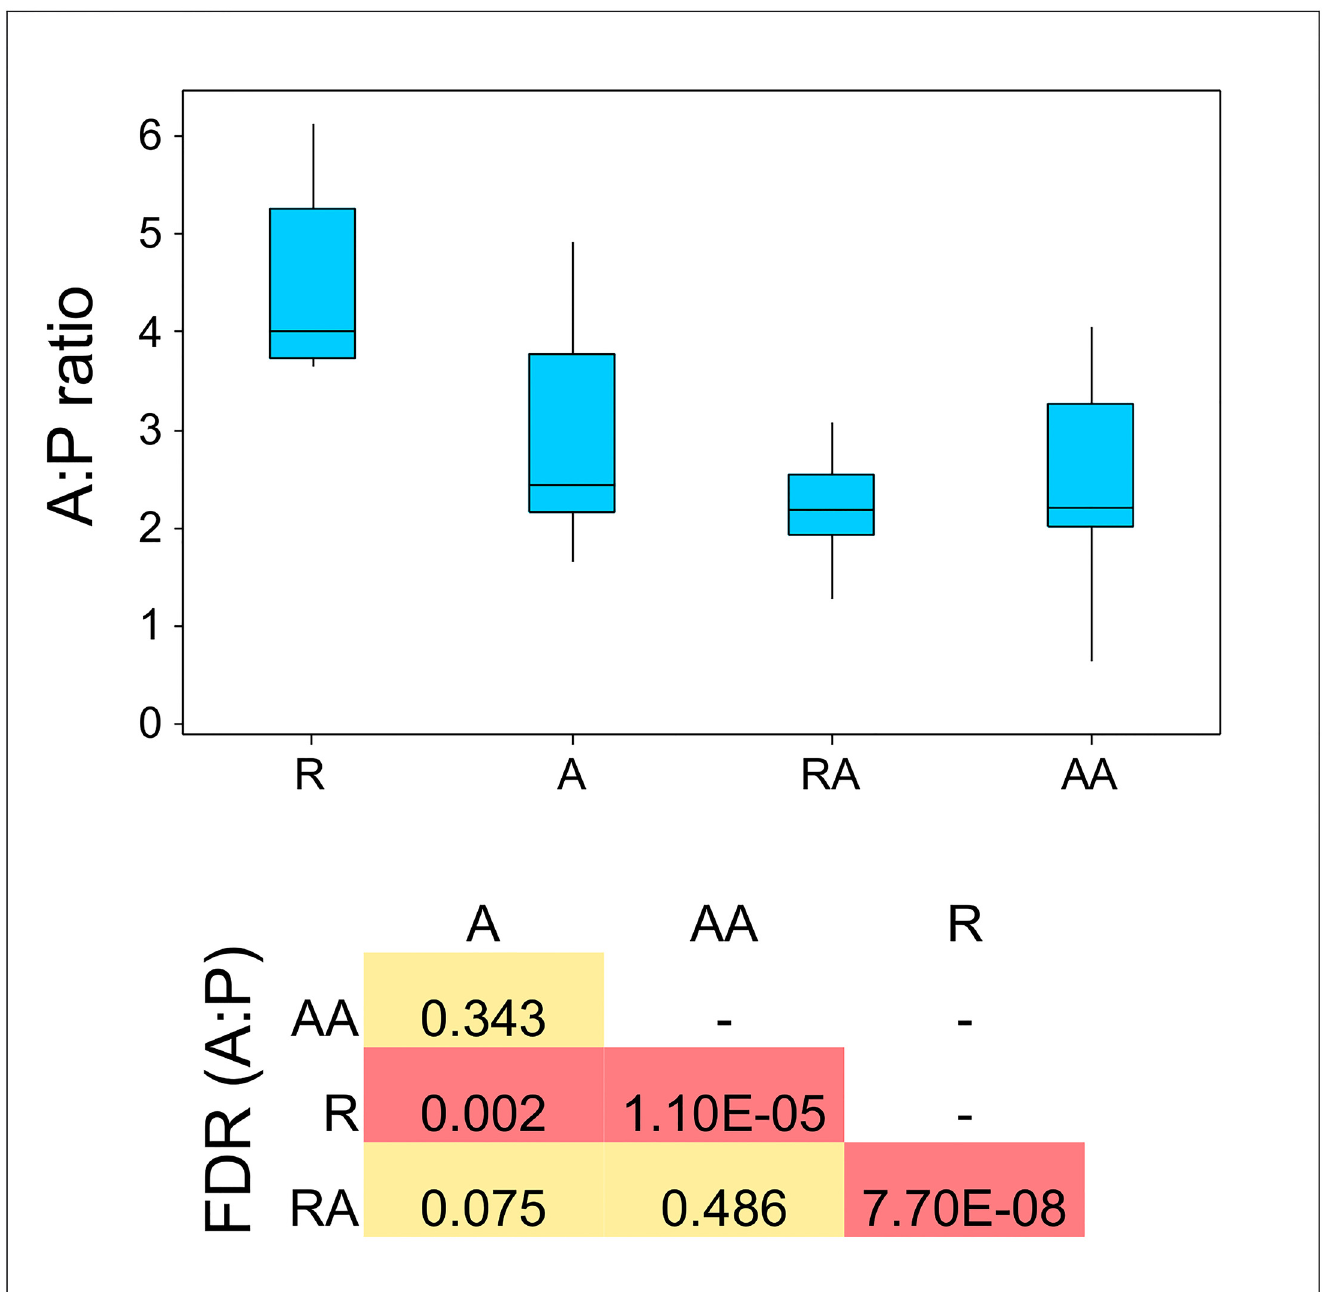
Fig 7. Acetate:Propionate (A:P) ratios in rumen samples from all groups. Group R (n = 14), A (n = 13), RA (n = 15) and AA (n = 13). Box and whisker plot showing median, quartiles, maximum and minimum values. FDR = BH-corrected P values derived from Wilcoxon pairwise comparisons of A:P ratios between different treatment